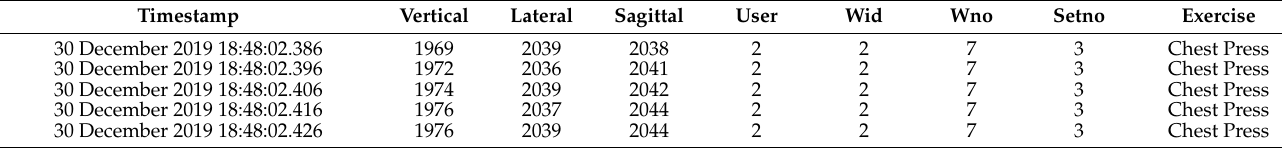
Table 3. Labeled body movement and mobile application